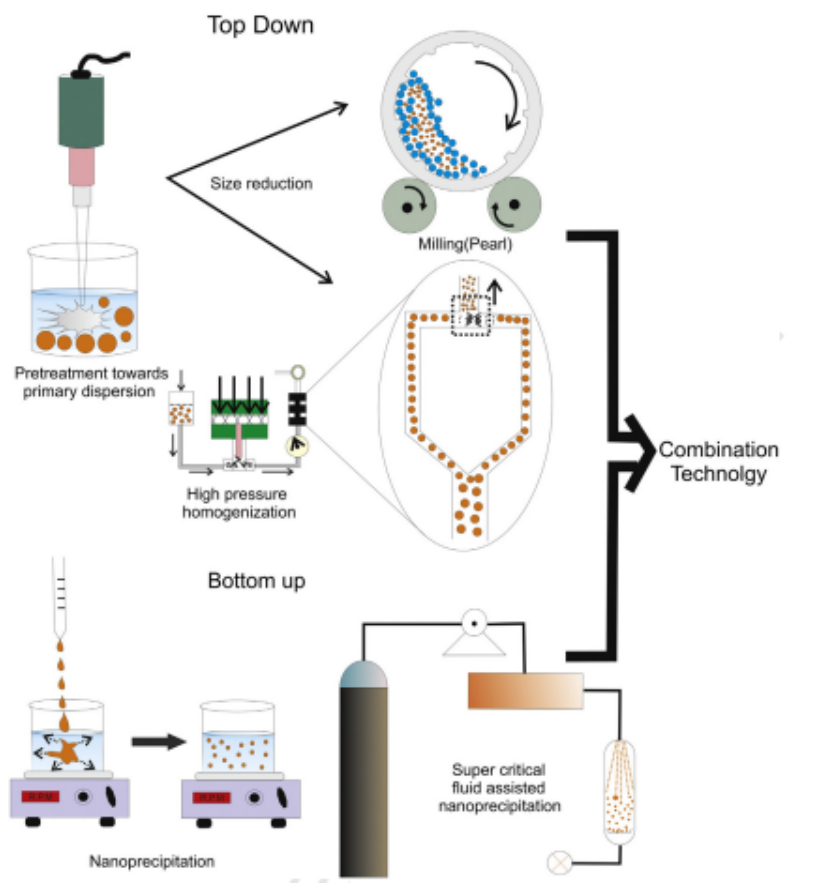
Figure 3. Schematic representation of the top-down method and bottom-up method (adapted from [76]. Copyright 2022, copyright holder Elsevier, Amsterdam).